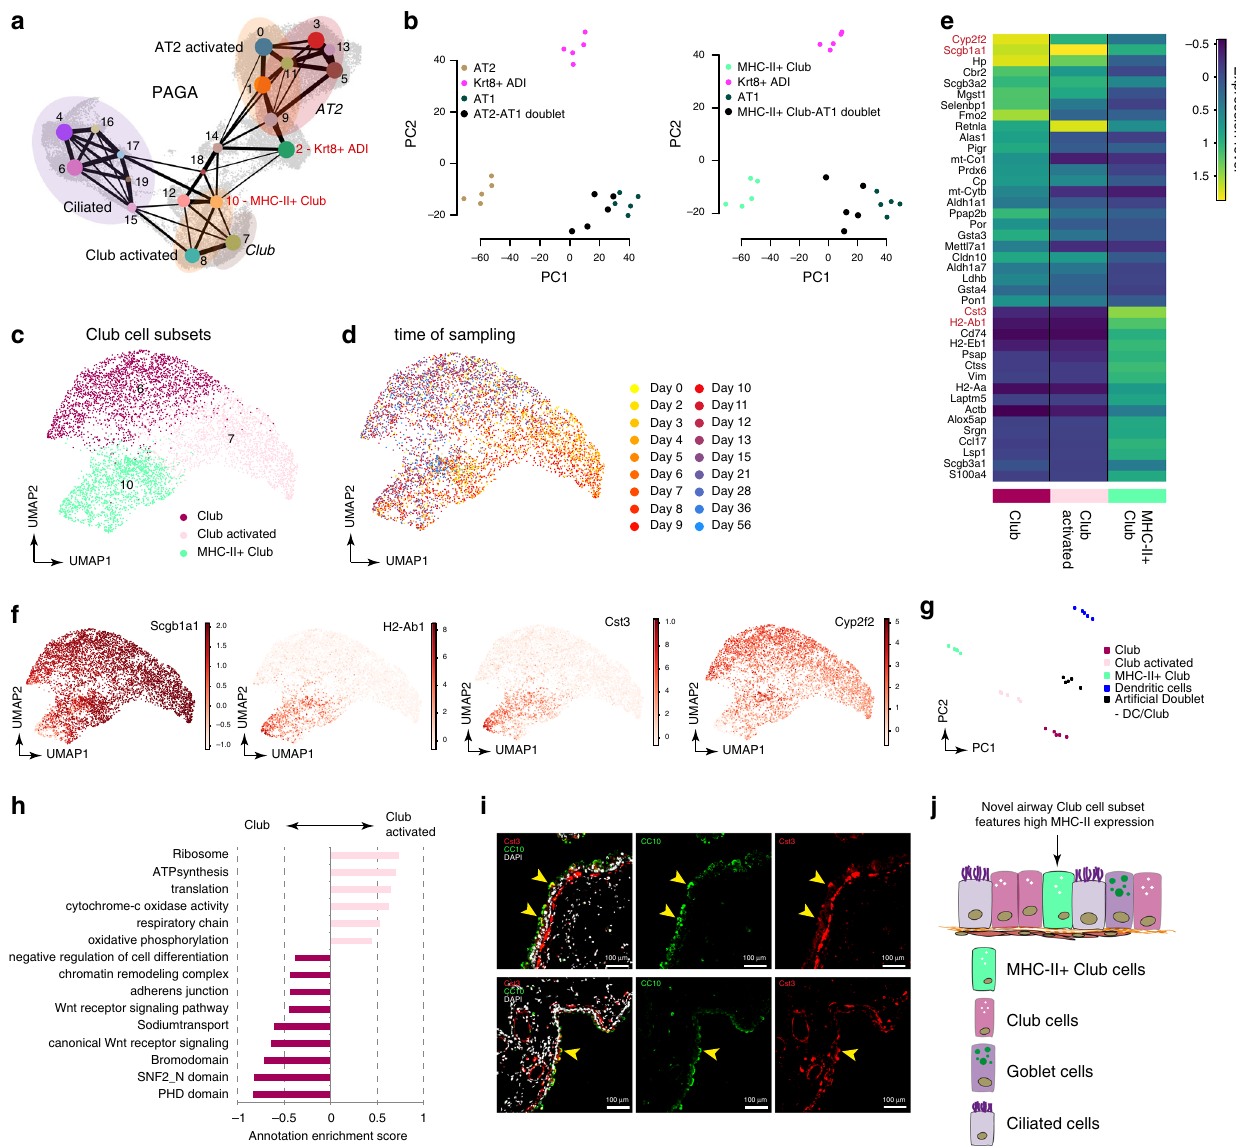
Fig. 5 A distinct club cell state shows high connectivity to alveolar cell identities after injury. a The PAGA graph visualizes potential cell-type transitions and the topology of the data manifold. Nodes represent Louvain clusters and thicker edges indicate stronger connectedness between clusters. b Principal component analysis of arti fi cially generated cluster-speci fi c and doublet in silico bulk samples shows that Krt8 + ADI cells map orthogonal with respect to linear activated AT2 to AT1 (left) and MHC-II + club to AT1 (right) differentiation pro fi les. In silico bulk samples are colored by cluster as derived from the PAGA map in ( a ). Arti fi cially generated doublets are colored in black. c , d The plots visualize the UMAP embedding of Club cells colored by Louvain clustering ( c ) and by time point ( d ). e The heatmap shows the average expression levels of marker genes across the three club cell clusters. f UMAP embeddings show distinct expression patterns for selected marker genes. g Principal component analysis of arti fi cially generated cluster-speci fi c and doublet in silico bulk samples shows that MHCII + club cells map orthogonal with respect to a linear connection between dendritic and club cells. Dendritic cell samples and arti fi cially generated doublets are colored in blue and black, respectively. h The bar graph shows the annotation enrichment score 78 for selected examples of gene categories with signi fi cant enrichment (FDR < 5%) in either activated Club (positive scores) or Club cells (negative scores). i Immuno fl uorescence staining of mouse airways shows CC10 + club cells (green) and Cst3 + cells (red), DAPI (white). Note the partial overlap of Cst3 + / CC10 + airway cells (highlighted by yellow arrowheads). Scale bar = 100 microns; representative images from n = 3 bleo-treated mice. j Revised model of club cell heterogeneity in mouse